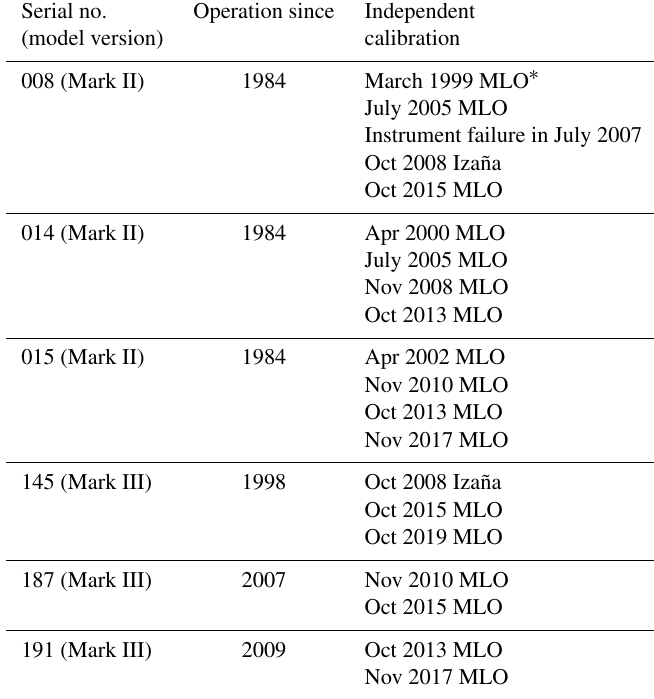
Table 2. Independent calibration history of world Brewer reference